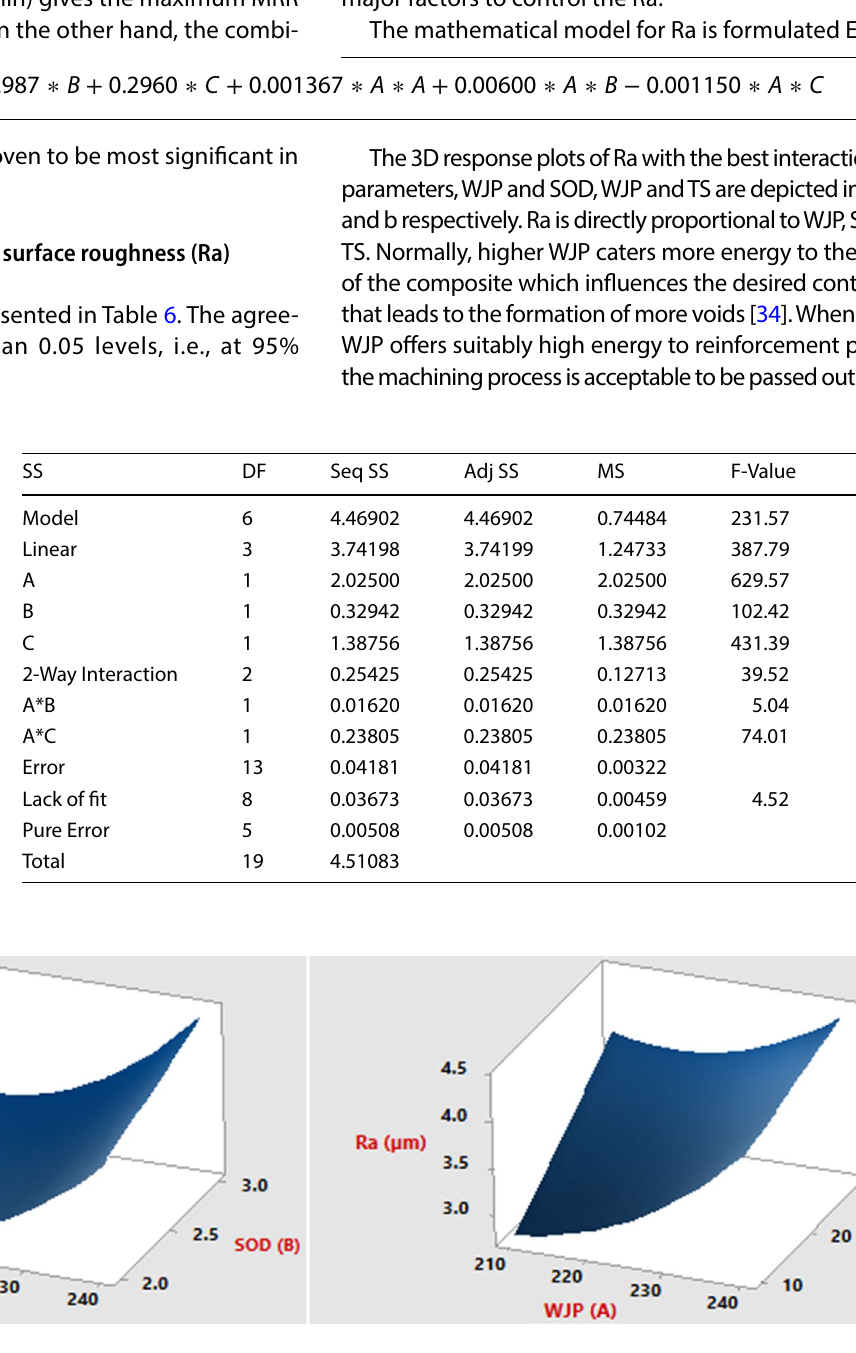
Fig.6 Response plot for Ra